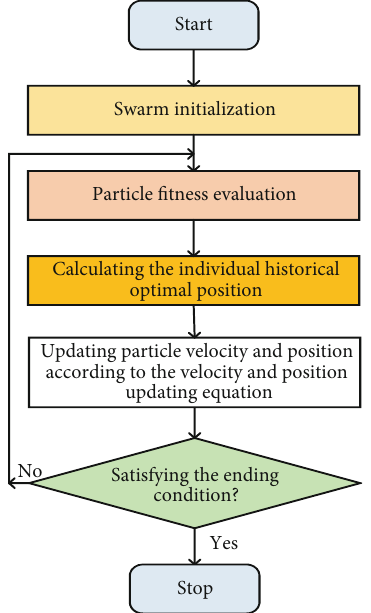
Figure 8: Flowchart for the PSO algorithm.